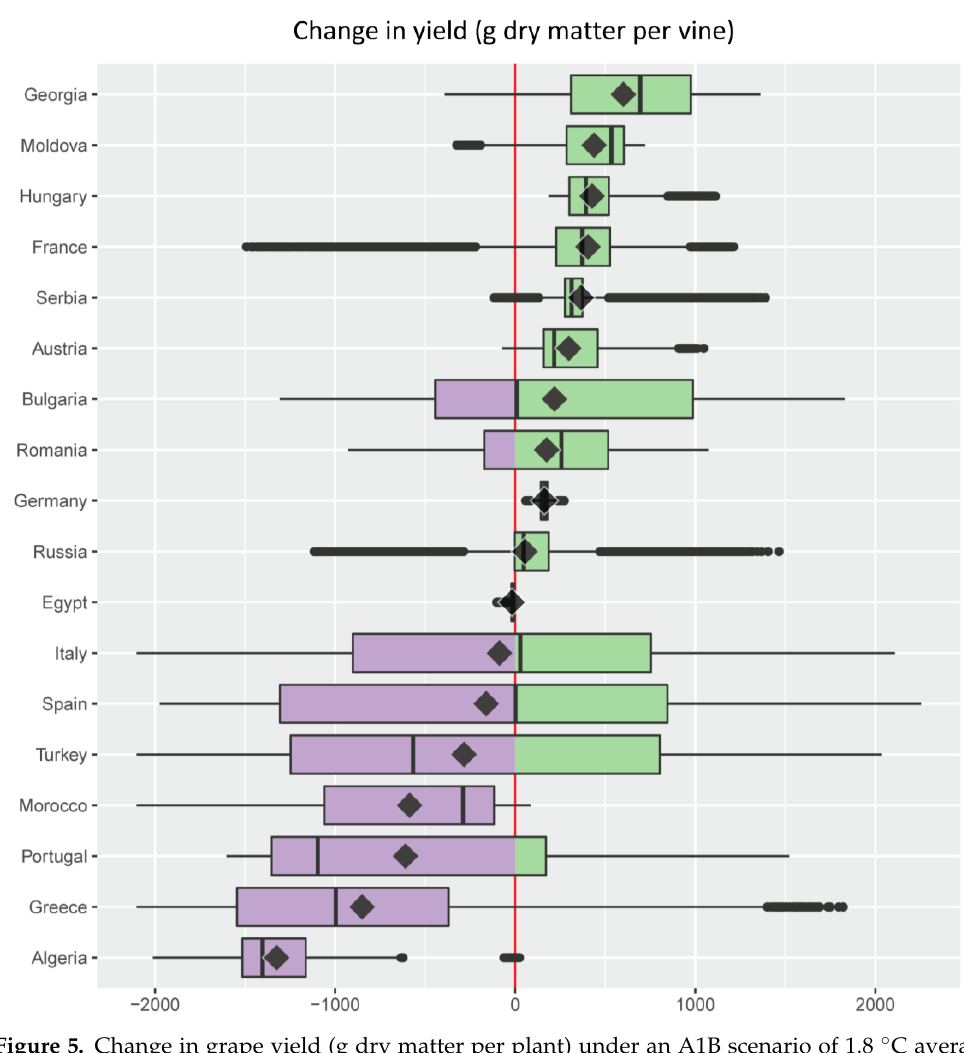
Figure 5. Change in grape yield (g dry matter per plant) under an A1B scenario of 1.8 °C average climate warming in the Euro-Mediterranean region illustrated as a series of stacked boxplots (graphics produced using the R package ggplot2 [72]), one for each of the 18 Euro-Mediterranean countries (Figure 2) having a grape growing area larger than 32 × 10 3 ha [67]. Box-and-whisker plots (boxplots) indicate the distribution of data with the vertical black line inside the box representing the median value, the left and right limits of the box being the 25th and 75th percentile (the lower and upper quartiles, respectively), and the whiskers indicating the minimum and maximum value unless outliers are shown as black points, in which case whiskers represent the lower quartile − (1.5 × the interquartile range) (IQR, a measure of statistical dispersion equal to the difference between upper and lower quartiles) and/or the upper quartile + (1.5 × IQR). The superimposed diamonds indicate the mean climate change impact, and boxplots are ordered using this parameter. The red line is a reference for no impact with violet filling indicating a negative change (decrease) and green a positive one (increase). Color palette from ColorBrewer